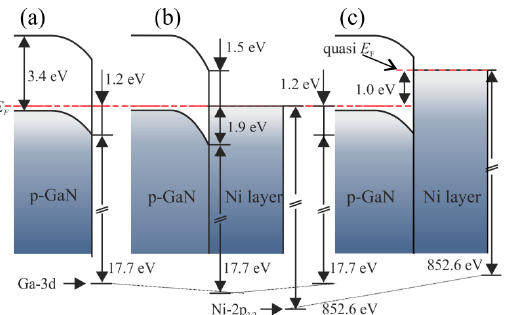
Figure 26. Band diagrams for ( a ) bare and Ni thin film ‐ covered p ‐ GaN(0001) surfaces ( b ) before and ( c ) after annealing.